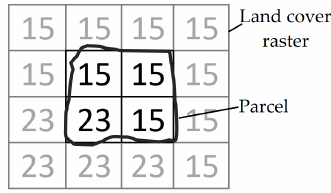
Figure 3. An example of parcel masking (15: Vineyard, 23: